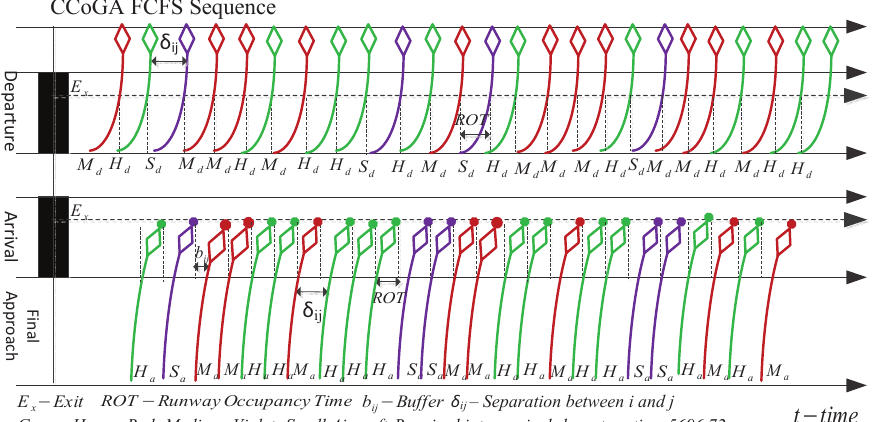
Figure 8. Time-space diagram of the FCFS sequence: initial arrival and departure of aircraft at final approach fix and runway threshold, respectively.